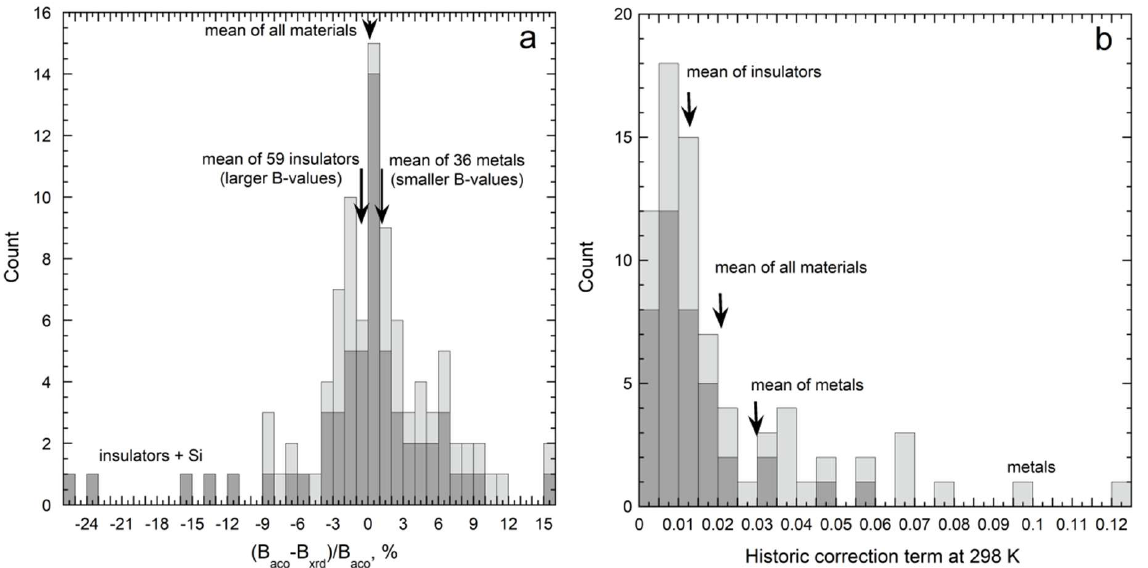
Figure 6. Statistical presentation of the data from compilations. See Figure 5 for literature sources. Light grey = metals; dark grey = insulators and Si. Arrows point to various mean values: ( a ) histogram of the difference between elasticity and volumetric measurements of bulk moduli, in percent; ( b ) histogram of the product αγ T at 298 K. Expansivity data were found for 39 of the insulators that had both types of bulk moduli measurements.